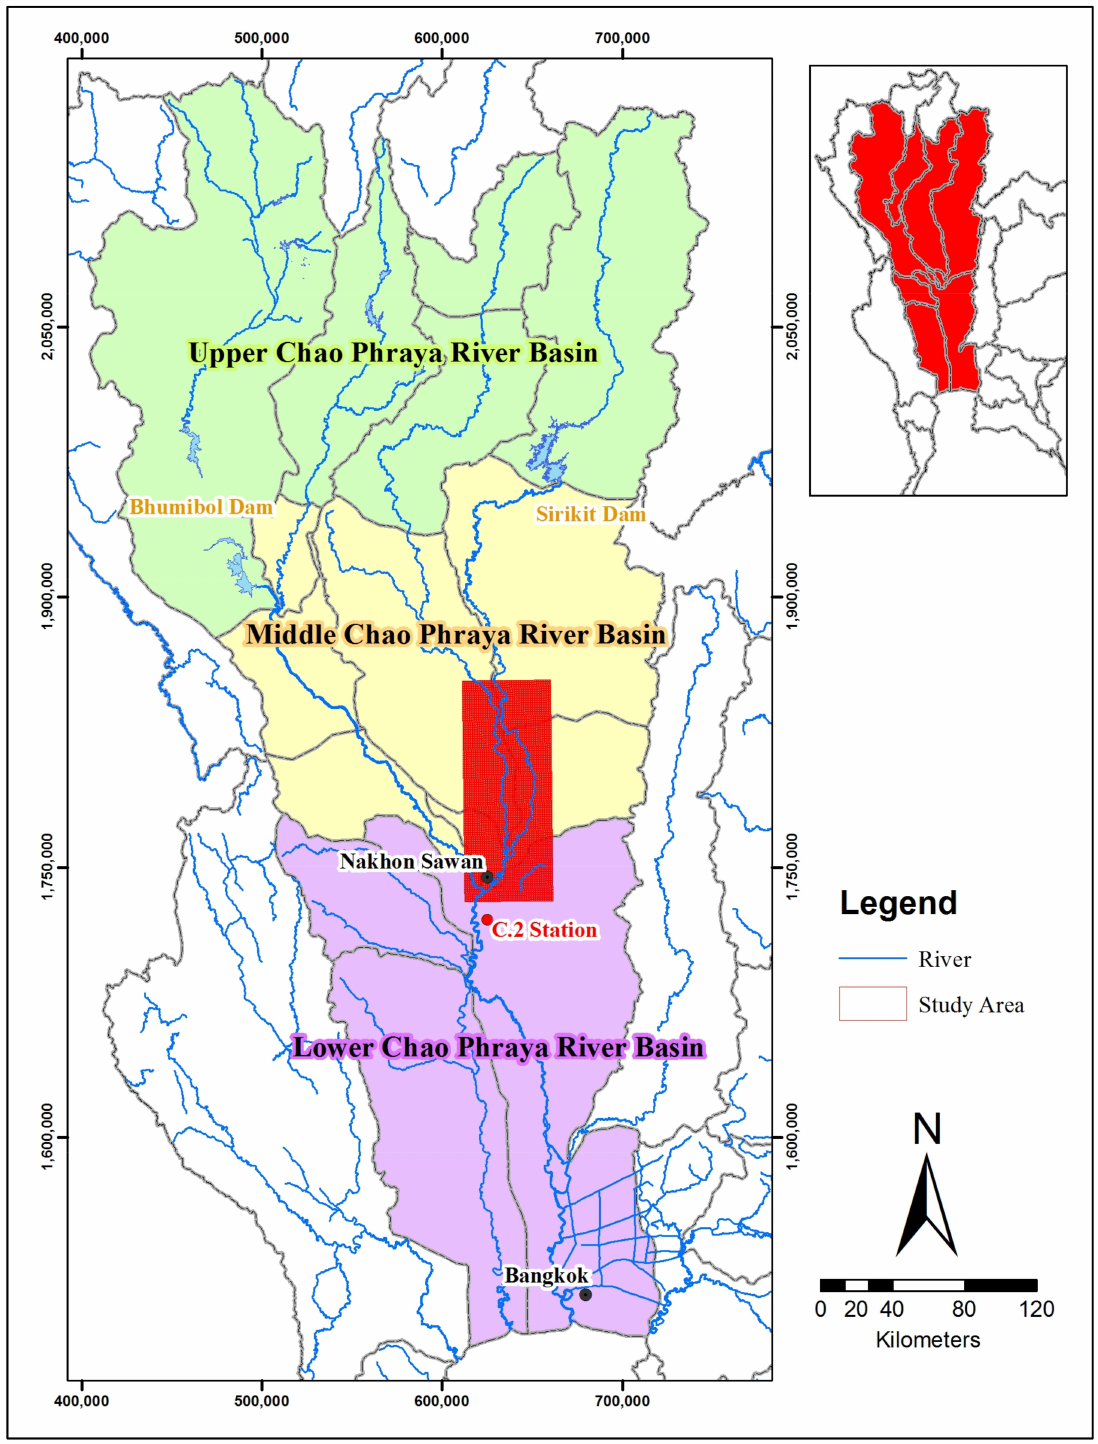
Figure 1. Study area for flood risk assessment and the emergency flood evacuation model in the middle reach of Chao Phraya River